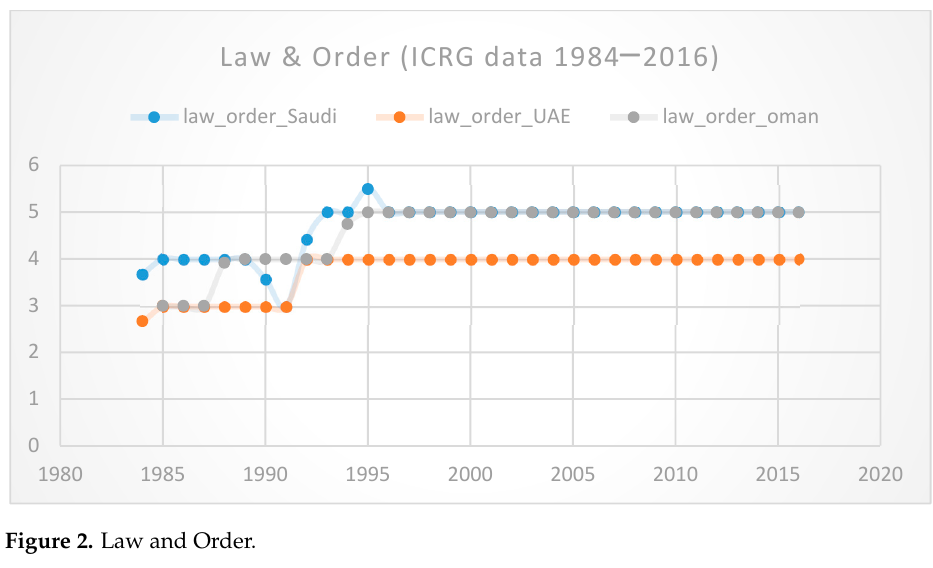
Figure 1. Corruption Level.